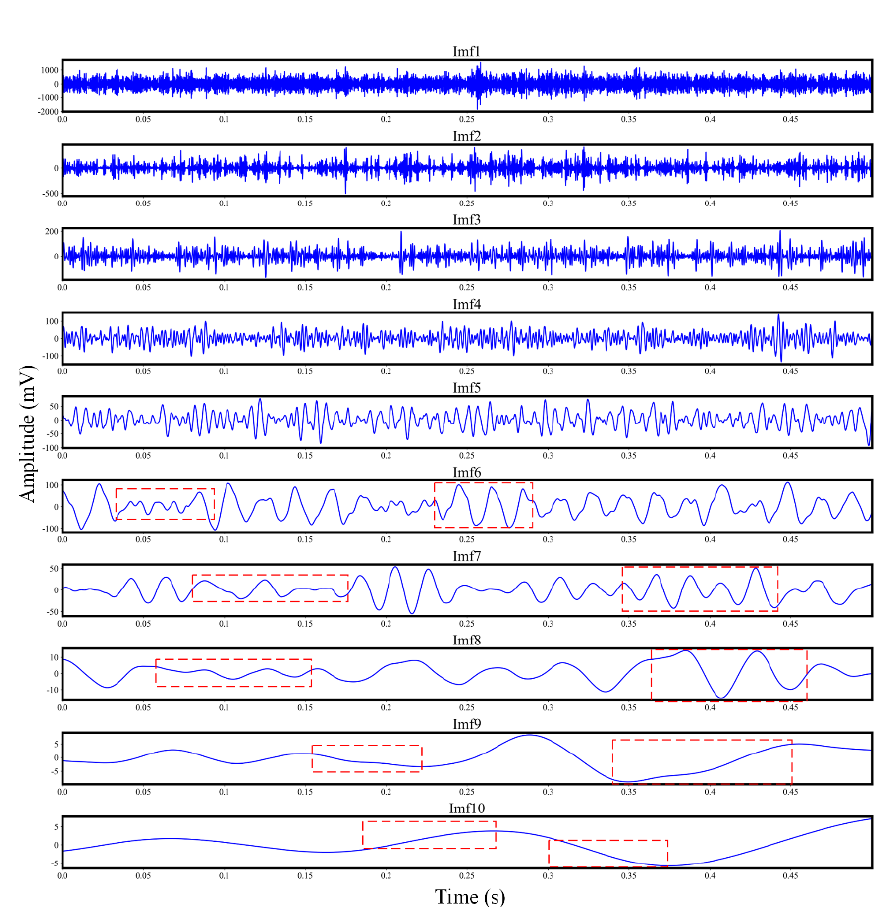
Figure 2. 10 sub-signals decomposed by complementary ensemble empirical mode decomposition (CEEMD).